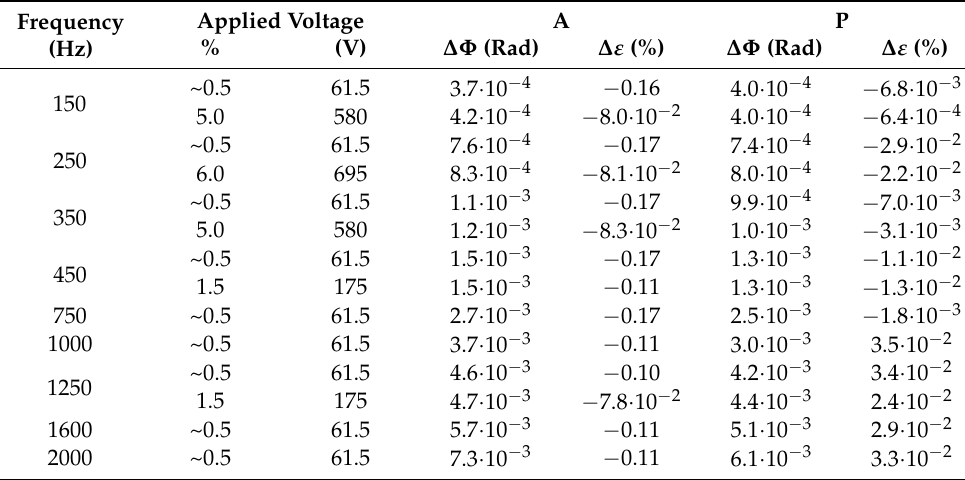
Table 6. ε and ∆ ϕ variations between the designed and the reference